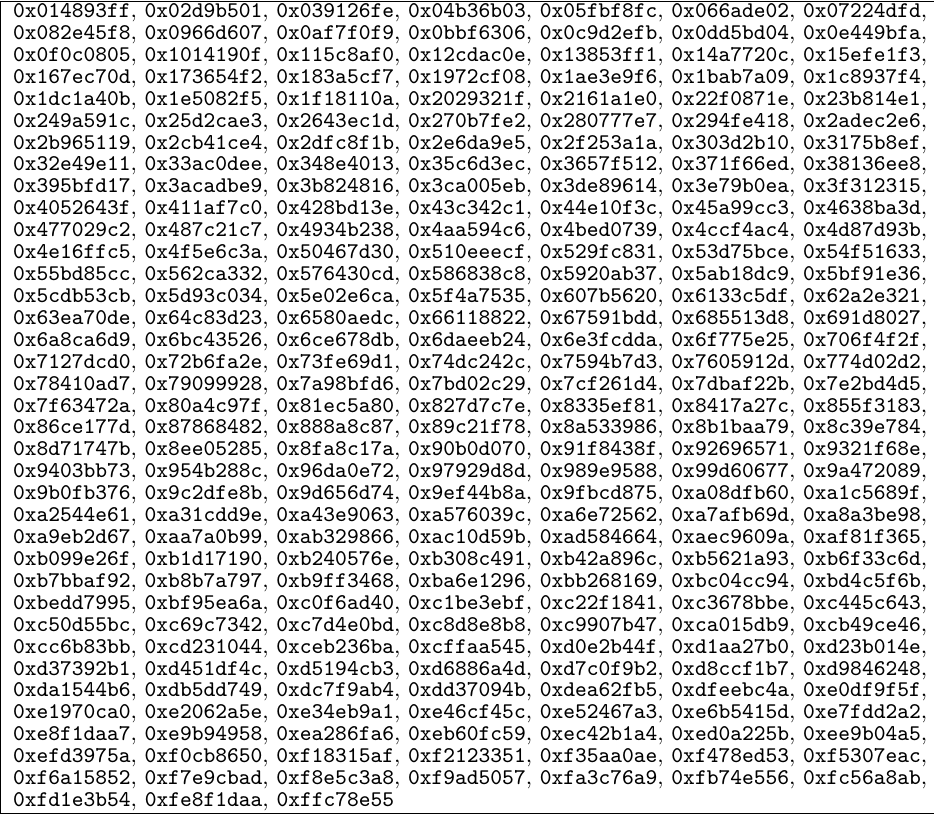
Table 3: All 255 choices of Λ id for Λ ∈ S id such that Λ 0 ∈ S